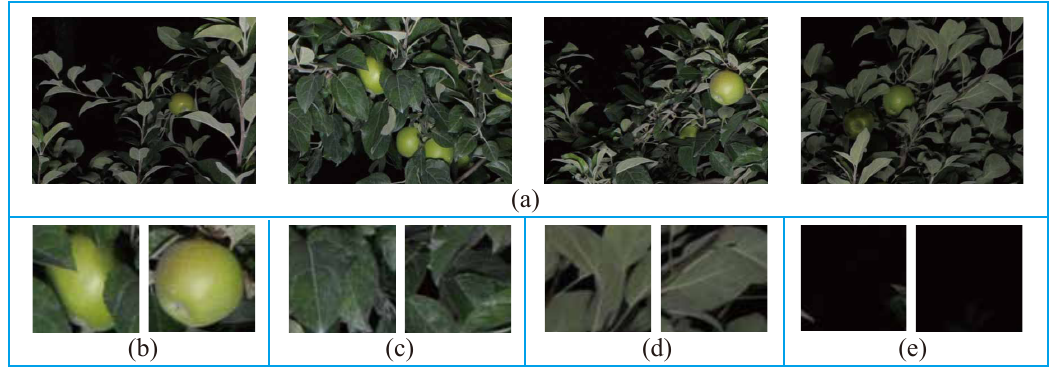
Figure 1. Some of the original images: ( a ) original images; ( b ) apple fruit; ( c ) up side of Leaves; ( d ) down side of leaves; ( e )